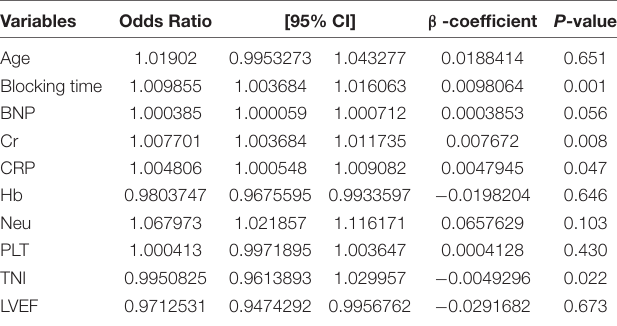
TABLE 2 | Beta coefficients and odds ratios of the PRIME Score.